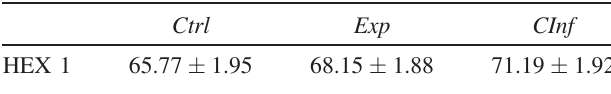
TABLE I. Average scores on Hex 1 for each